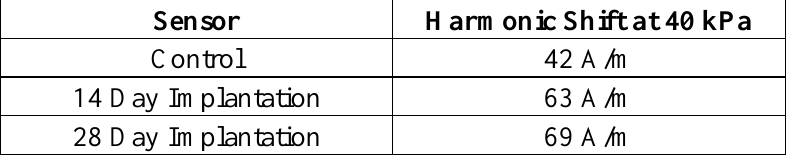
Table 3. The pressure response for the reference and implanted sensor at 14-day and 28-day implantation time.